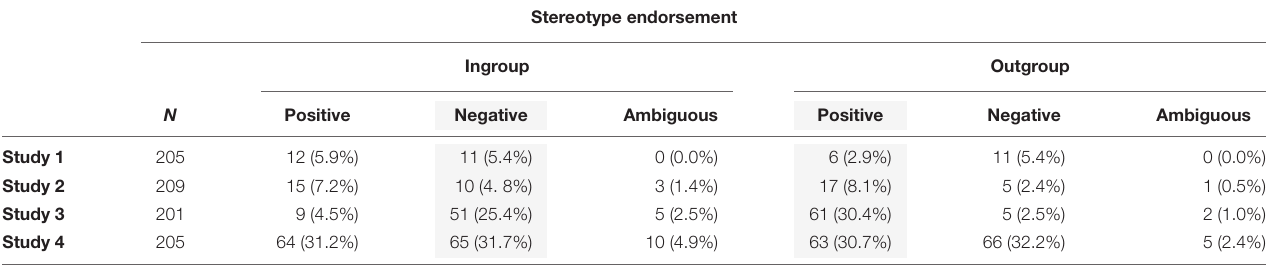
TABLE 2 | Frequency of endorsed stereotypes (percentages in